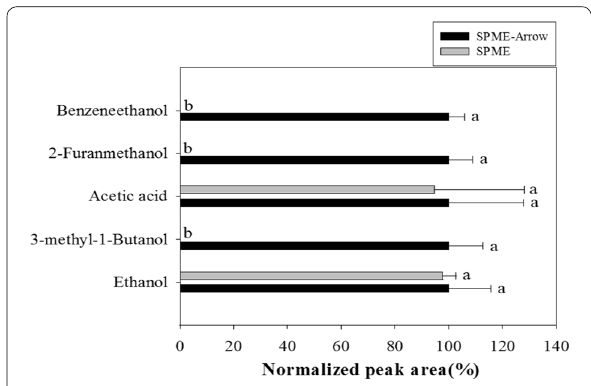
Fig. 5 Overall comparison of volatile compounds extracted by SPME and SPME‑Arrow